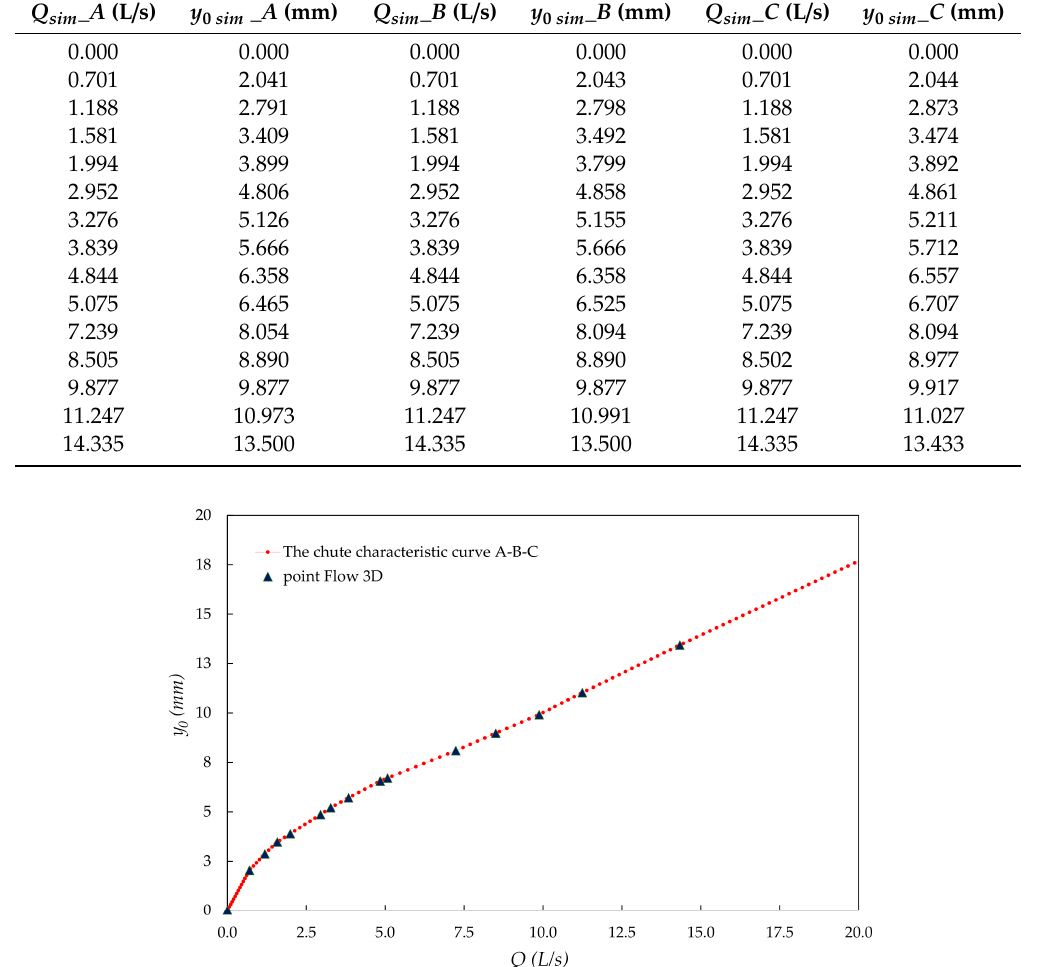
Figure 11. Three chute characteristic curves , with radius of 0.2 m ( A ), 0.3 m ( B ) and 0.4 m ( C ), are visually overlapped because they only di ff er slightly on the initial curved part.